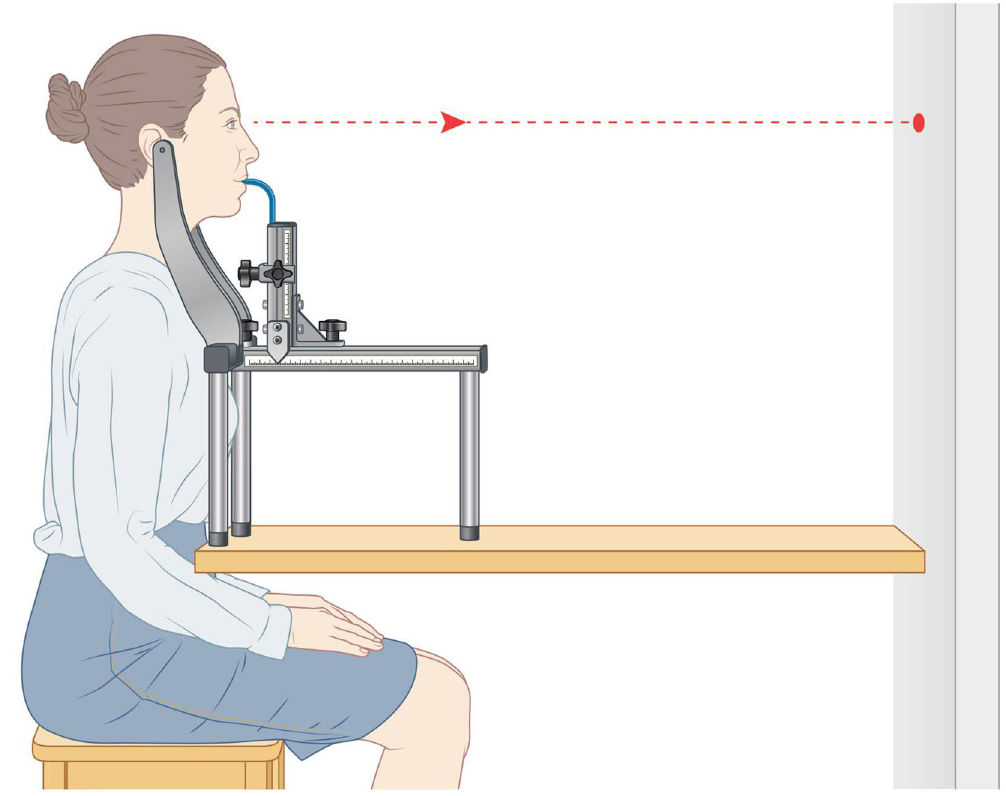
Figure 2. Fixation device. Created by Rogier Trompert Medical